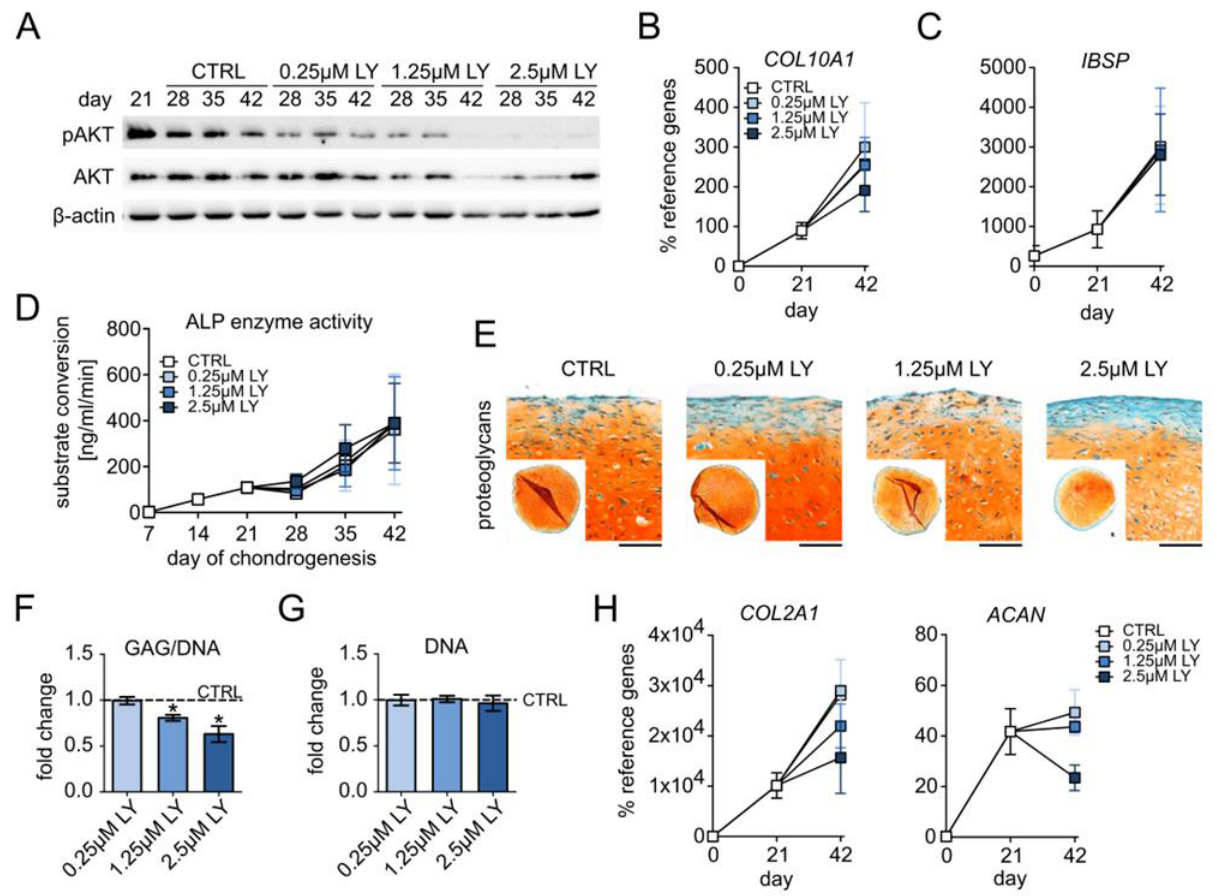
Figure 4. Pro-chondrogenic instead of pro-hypertrophic function of PI3K/AKT activity. MSC pellets were subjected to chondrogenic culture for 6 weeks and treated with 0.25 µM, 1.25 µM, or 2.5 µM LY294002 (LY) or 0.01% DMSO solvent (CTRL), starting from day 21 of chondrogenesis. ( A ) Western blot analysis for pAKT and AKT protein levels using β -actin as loading control. Shown is one representative of three independent experiments. ( B , C ) Gene expression analysis by qPCR for the hypertrophy marker COL10A1 and the osteogenic marker IBSP using CPSF6 and RPL13 as reference genes. ( D ) ALP enzyme activity was determined in pooled supernatants from four pellets per group and time point. ( E ) Paraffin sections of day 42 MSC pellets were stained with Safranin O/Fast Green to visualize proteoglycan deposition. Scale bars: 100 µm for enlarged sections and 1mm for overviews. ( F ) GAG content at day 42 was assessed via DMMB assay and referred to the DNA amount. ( G ) DNA content per pellet at day 42 was quantified via Pico Green assay. ( H ) Gene expression analysis by qPCR for the chondrogenic markers COL2A1 and ACAN using CPSF6 and RPL13 as reference genes. n = 3 independent MSC donor populations for each experiment. Graphs show means ± SEM. * p ≤